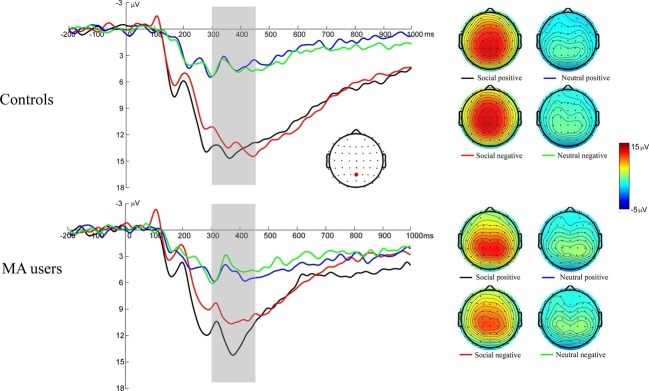
Left: FB-P3 responses to social positive and negative feedback on SID. Feedback onset was at 0 ms. Fb-P3 was scored as the averaged activity from 300 to 450 ms following feedback onset. Right: The scalp distributions of the ERP responses to positive and negative feedback on SID.